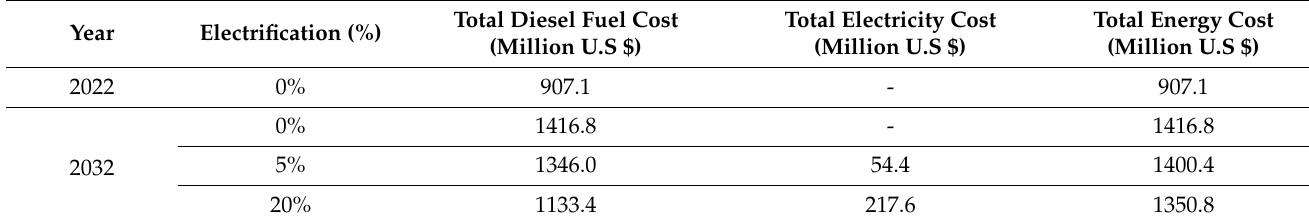
Table 4. Total energy costs for freight transport modes in Westbank,